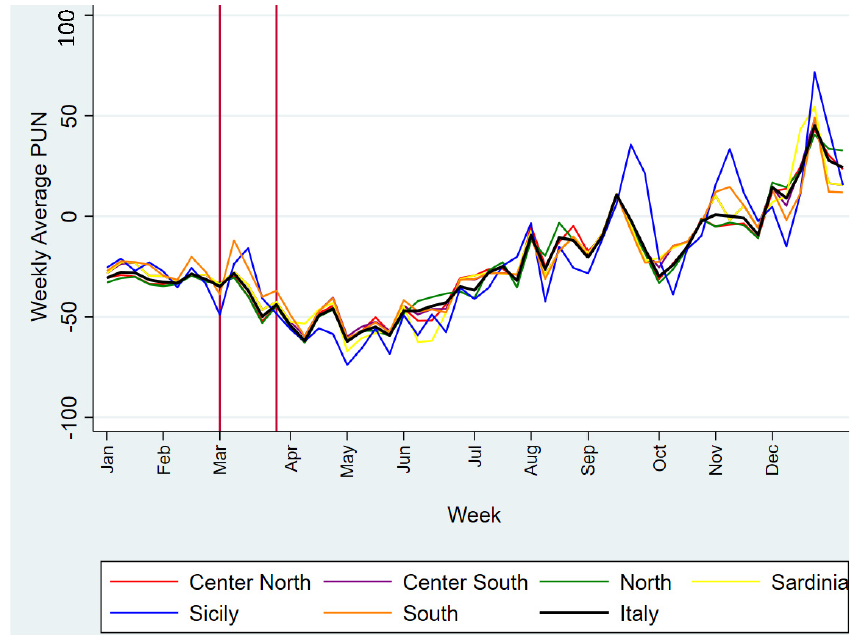
Figure 5. Relative Annual Variation (2020 vs. 2019) of Market Equilibrium Prices (PUN)-Weekly Average.